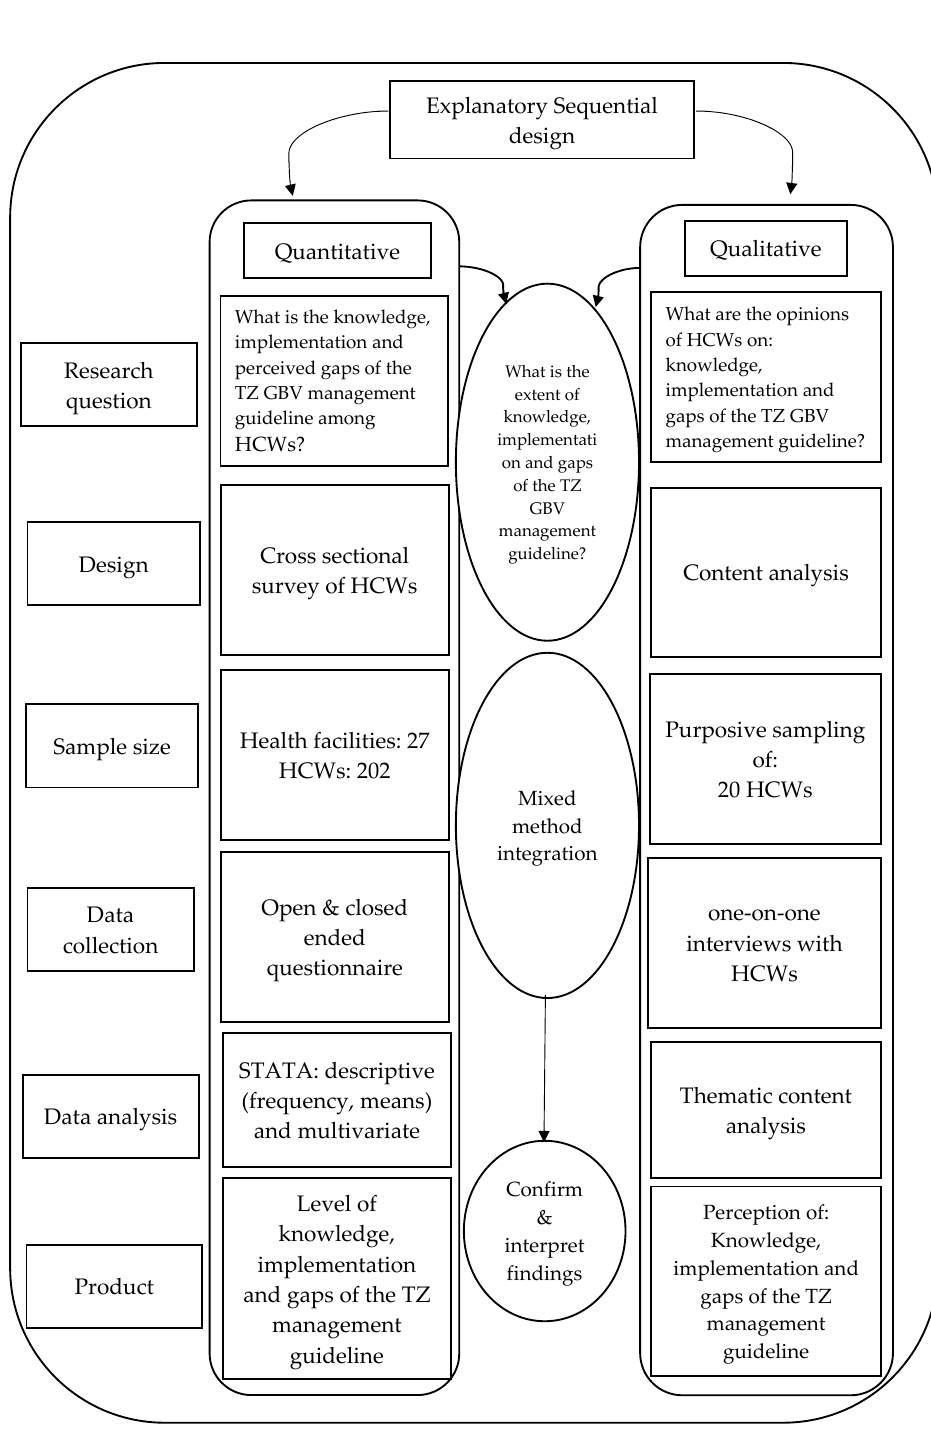
Figure 1. Explanatory sequential mixed methods procedural